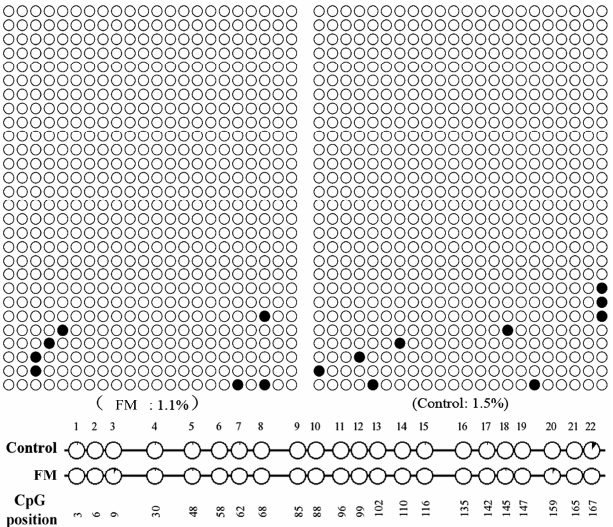
Figure 6. Methylation analysis of CEBPA promoter. No significant difference of methylation level between FM and the control was found in the region from − 172 to +2 bp in CEBPA promoter with the Quantification Tool for Methylation Analysis on line.